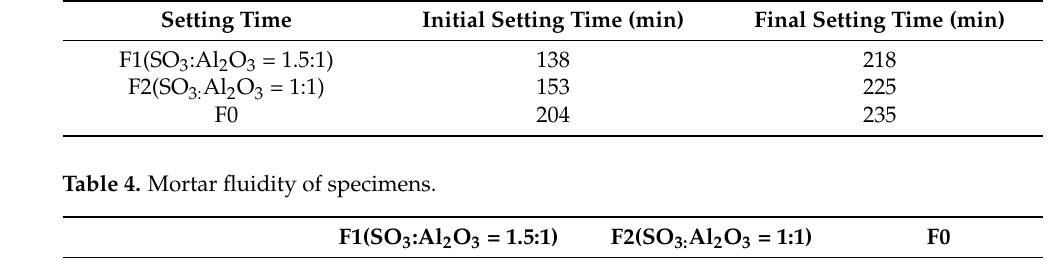
Table 3. Setting time of specimens.